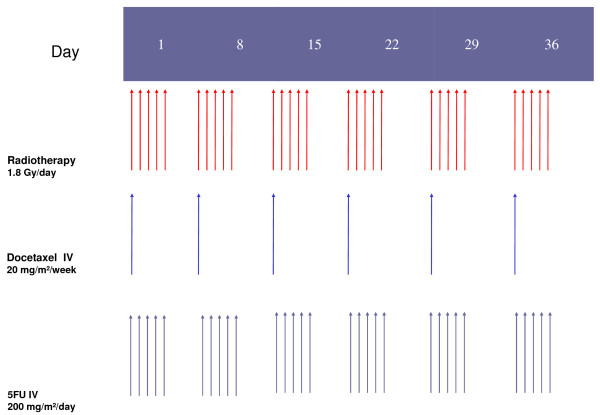
Treatment schedule: 5-FU + docetaxel + radiotherapy.